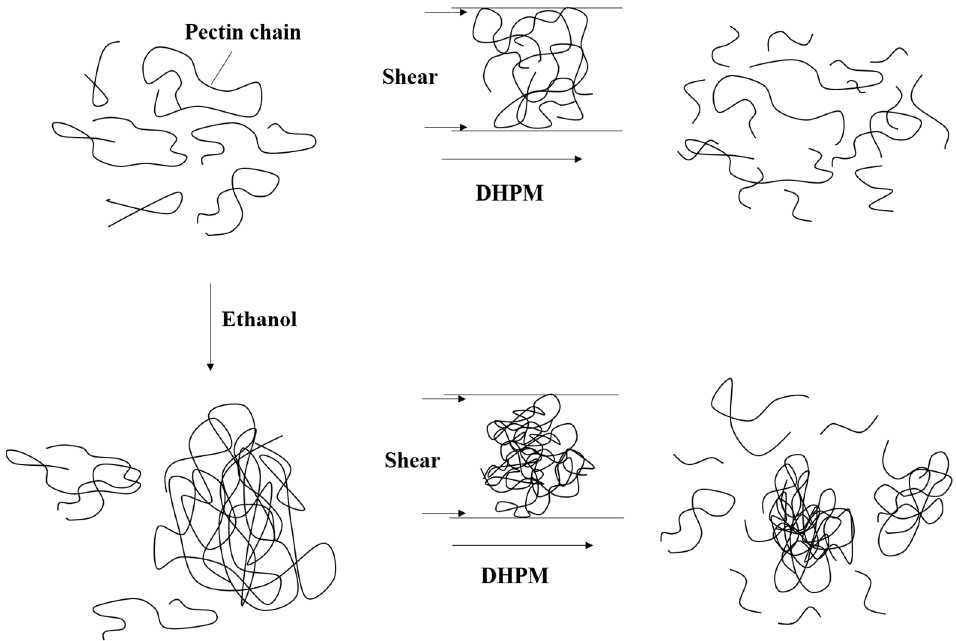
Figure 7. Schematic diagrams to illustrate the disaggregation and degradation process of pectin treated by DHPM in the water-ethanol system.